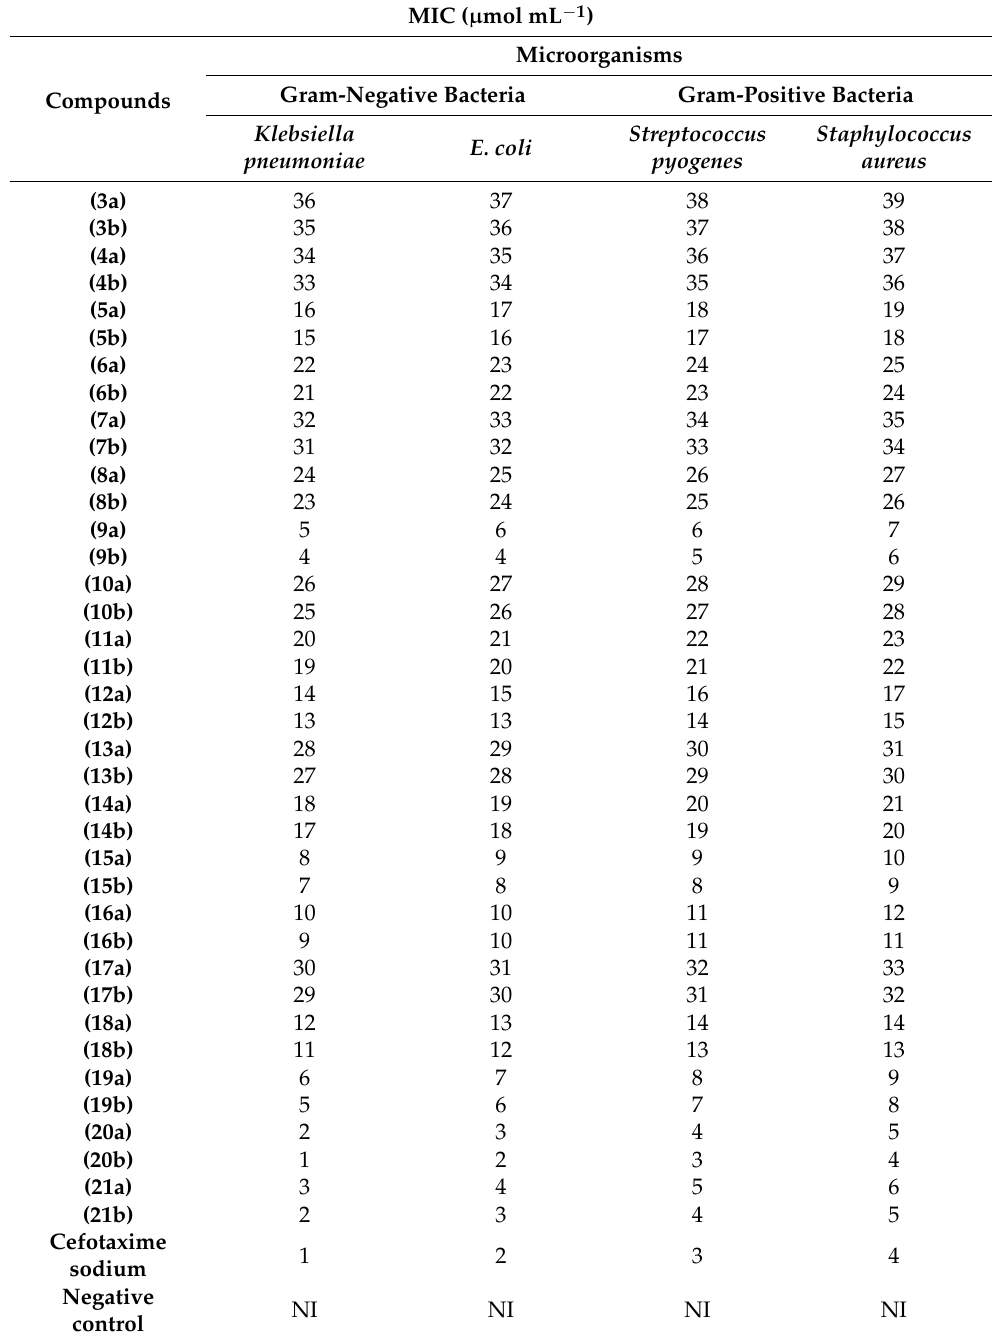
Table 1. A minimum inhibitory concentration of the compounds against